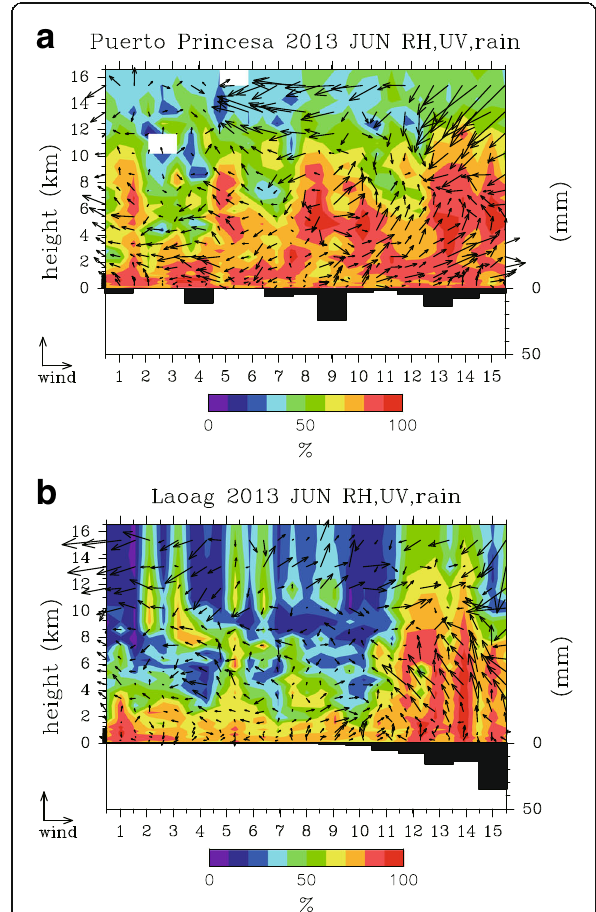
Fig. 8 Atmospheric profile during June 1 – 15, 2013. Vertical profiles of relative humidity (shading), horizontal wind (vector), and daily rainfall (bars) at a Puerto Princesa and b Laoag during June 1 – 15, 2013. Unit vectors represent 12.5